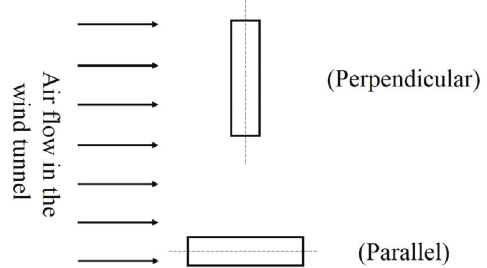
Fig. 2. Plan view of relative positions of the rectangular pan to the tunnel flow